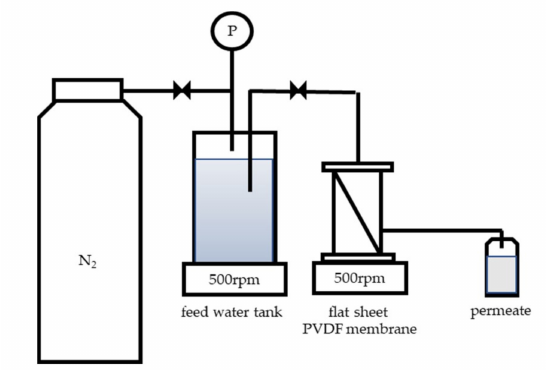
Figure 2. Experimental setup for the filtration of feed water particles through a flat sheet